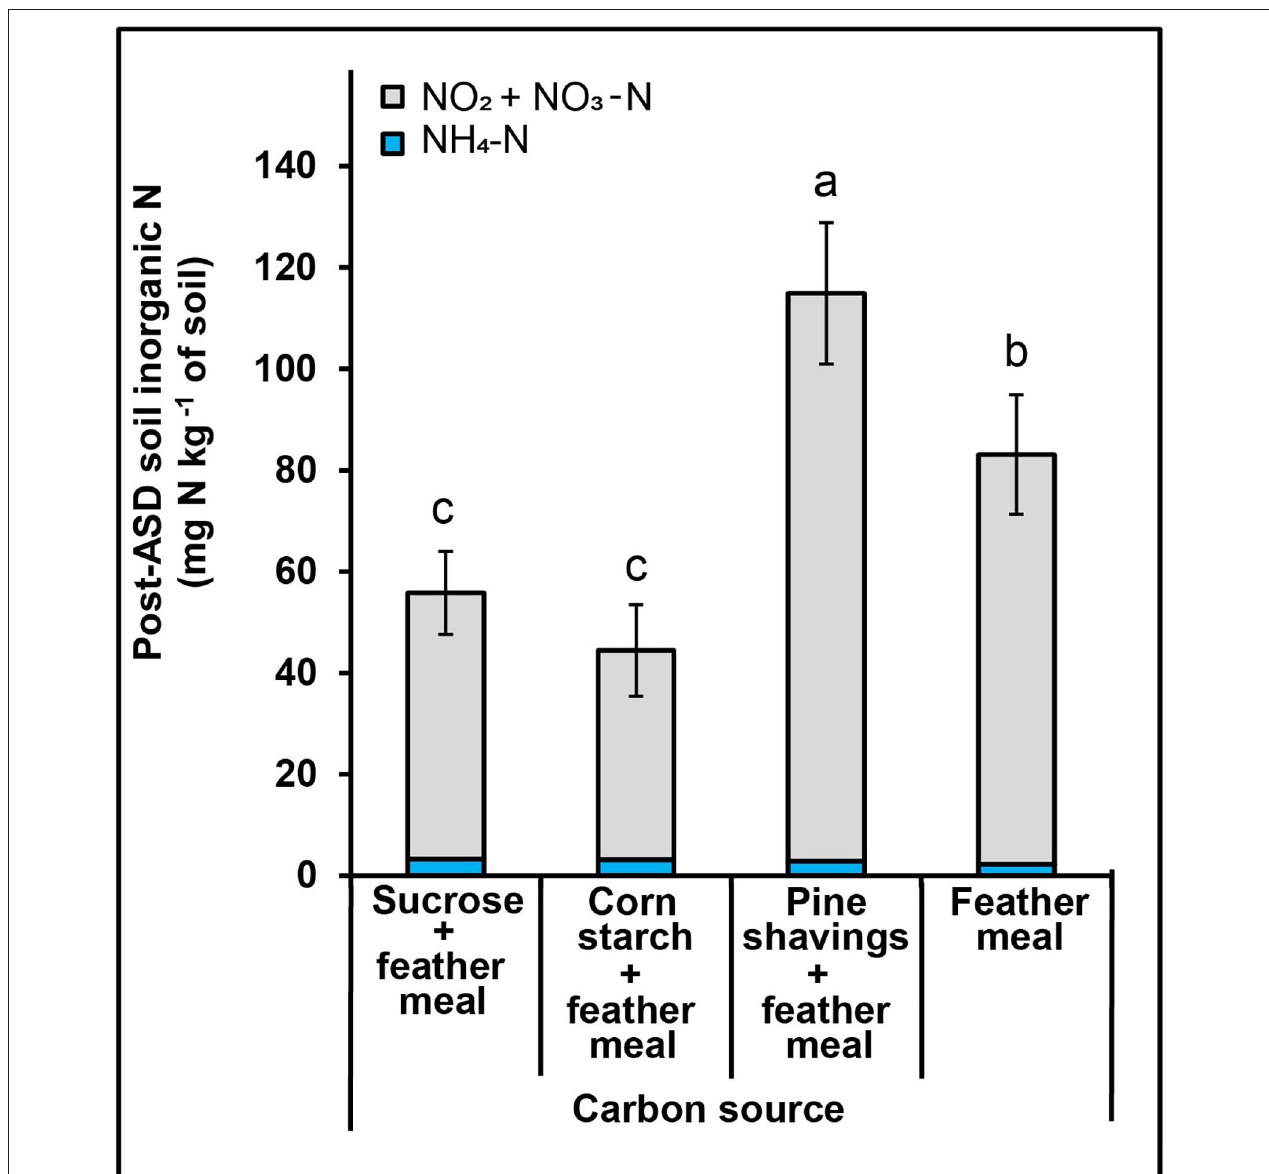
FIGURE 5 | Effect of ASD amendment (various C substrate) on soil inorganic N post-ASD treatment high tunnel study, trial 4. Bars indicated by similar letters are not significantly different at P < 0.05 according to Fisher’s protected LSD test. Error bars indicate standard error with twelve